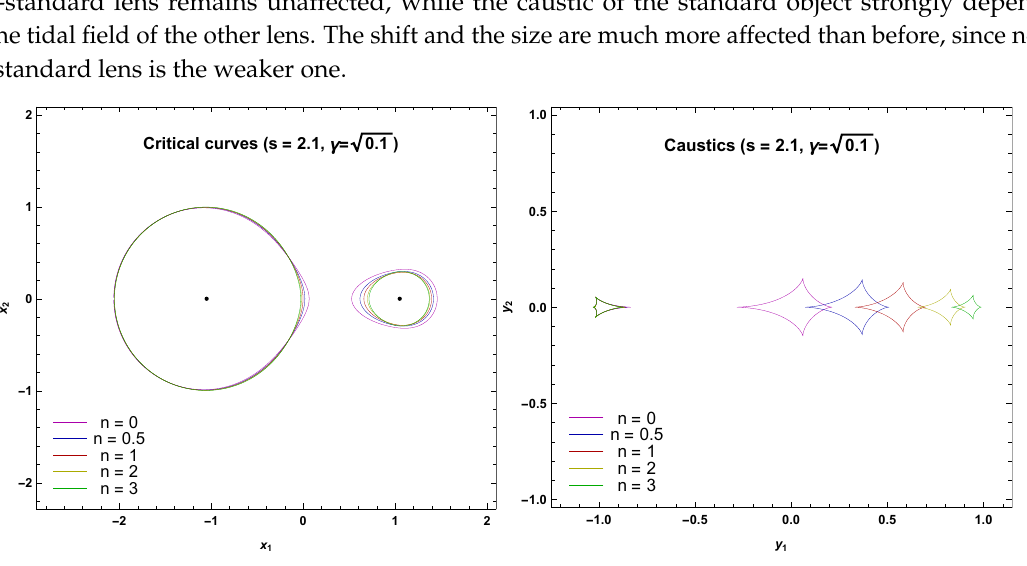
Figure 12. Critical curves and caustics in the unequal-strength binary with the standard lens on the right, wide separation. Here and in the following figures the lens on the right has m = 1 and the lens on the left has variable n